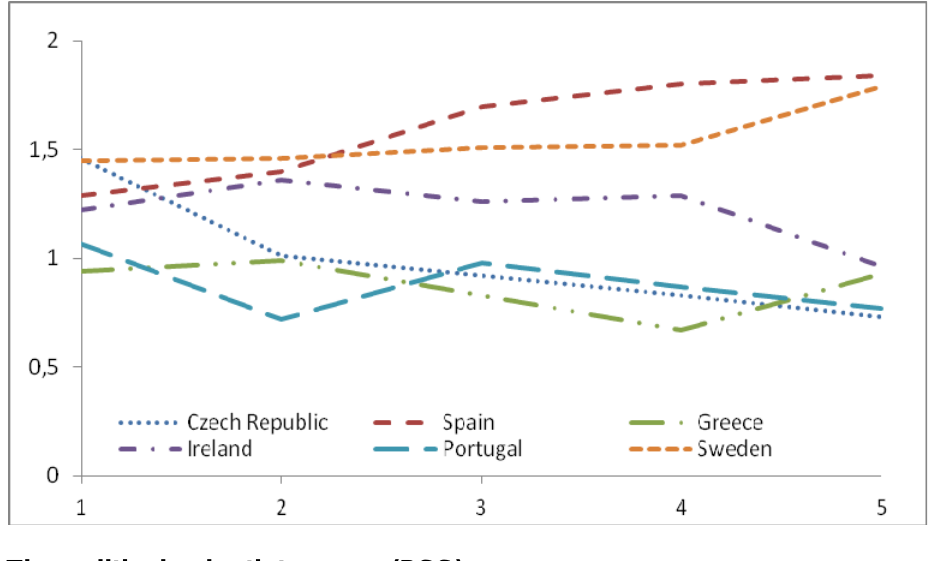
The political scientist survey